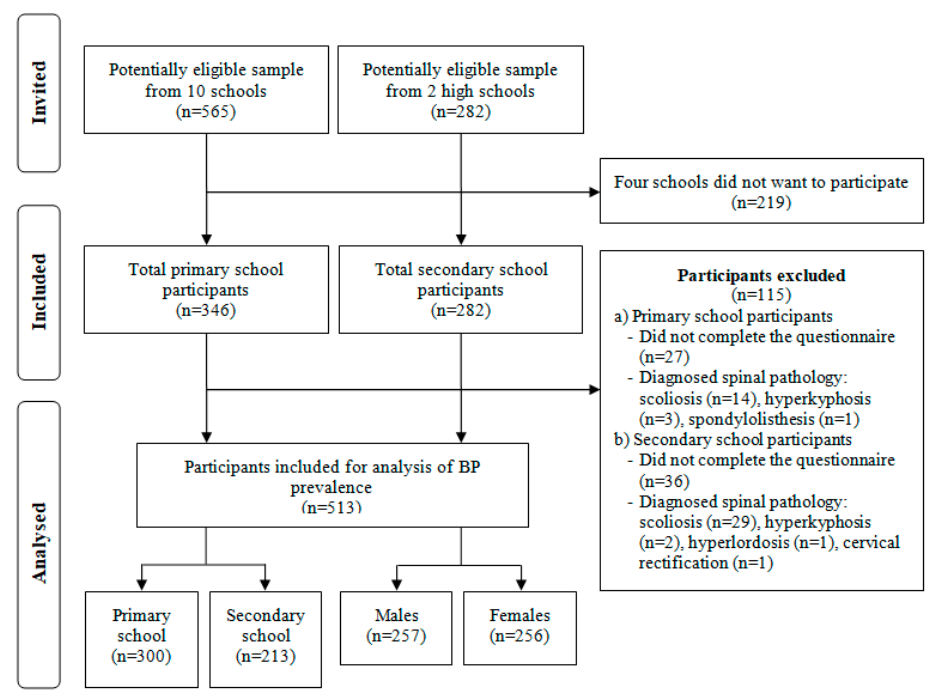
Figure 1. Flow diagram for the sample selection.